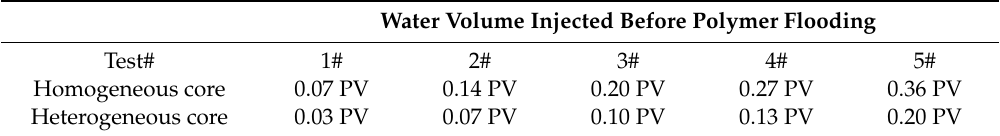
Table 2. Polymer injection timing.